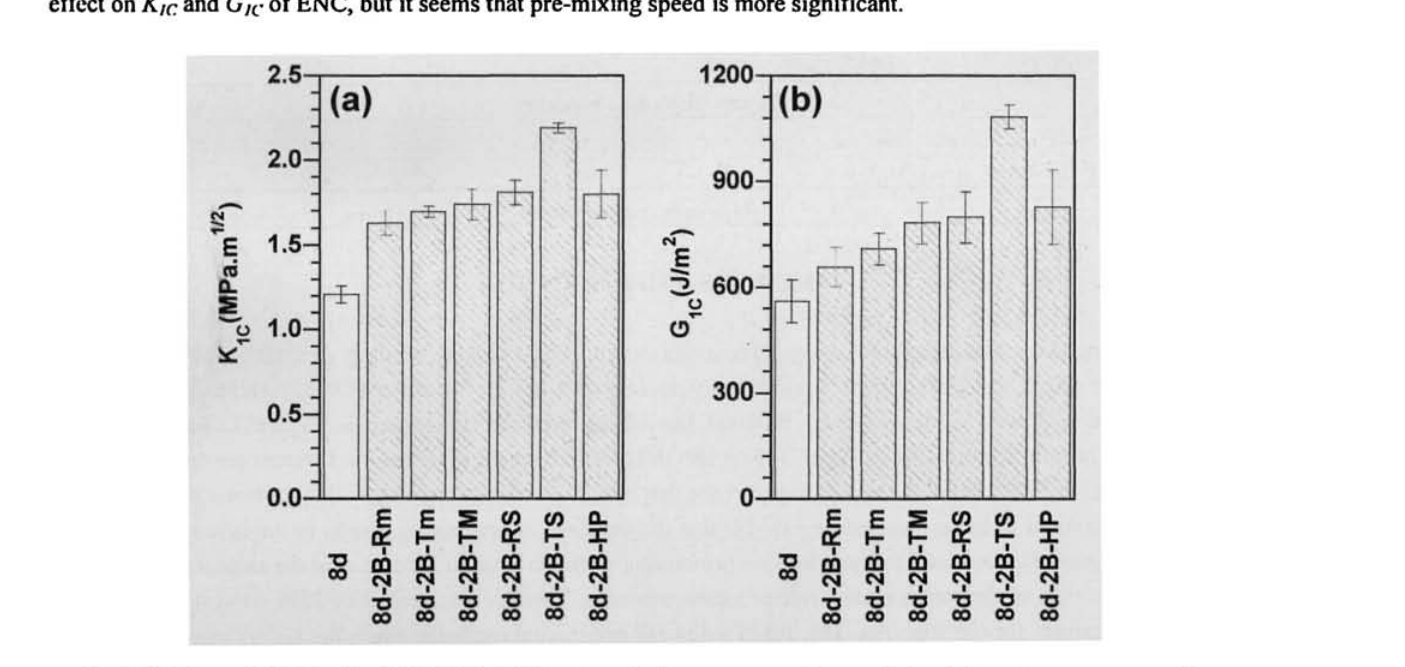
Fig. 3: (a) KK· and (b) G κ- for EPON828-D230 resin and its nanocomposites made by different pre-mixing